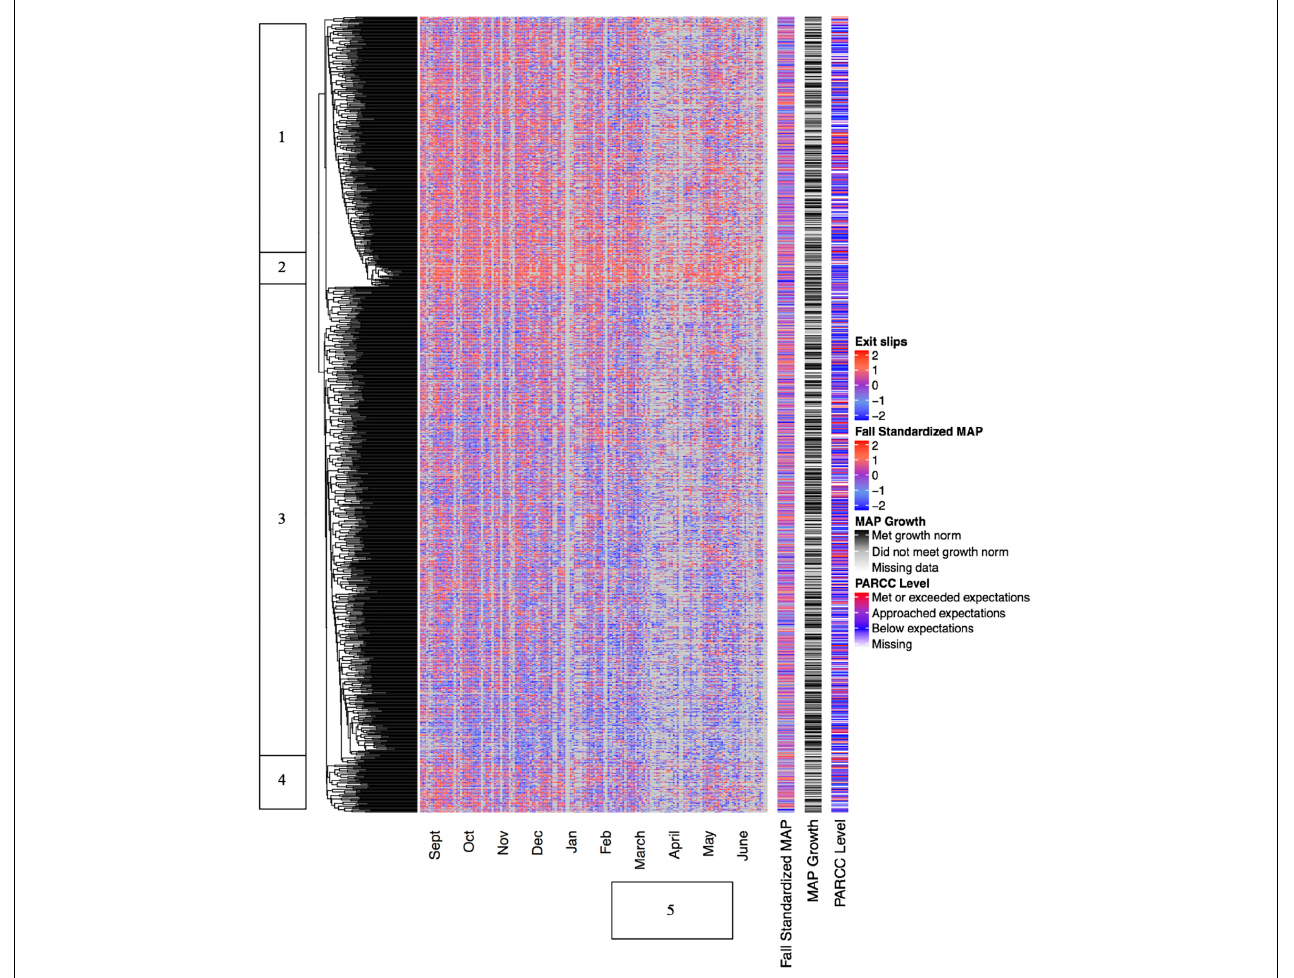
FIGURE 4 | Standardized daily exit slip scores displayed